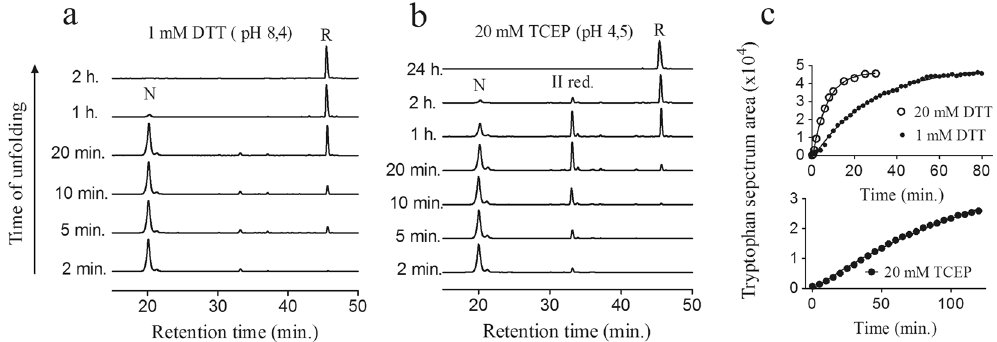
Figure 4. Reductive unfolding of native NvCI. Native NvCI was treated with: ( a ) 1 mM DTT in Tris-HCl (pH 8.4) and ( b ) 20 mM TCEP in sodium acetate (pH 4.5). Time course intermediates were trapped by acidification and analyzed by RP-HPLC. N and R stand for native and reduced NvCI; II for an intermediate that accumulates upon reduction with 20 mM TCEP. ( c ) Reductive unfolding of native NvCI followed by changes in tryptophan fluorescence spectra, after the addition of reducing agents. Native NvCI was reduced with TCEP (20 mM) in sodium acetate pH 4.5 (graph below) and DTT (1.0 and 20 mM) in Tris.Cl pH 8, 4 (graph above). Tryptophan fluorescence spectra were measured over time and the spectrum area was plotted as a function of